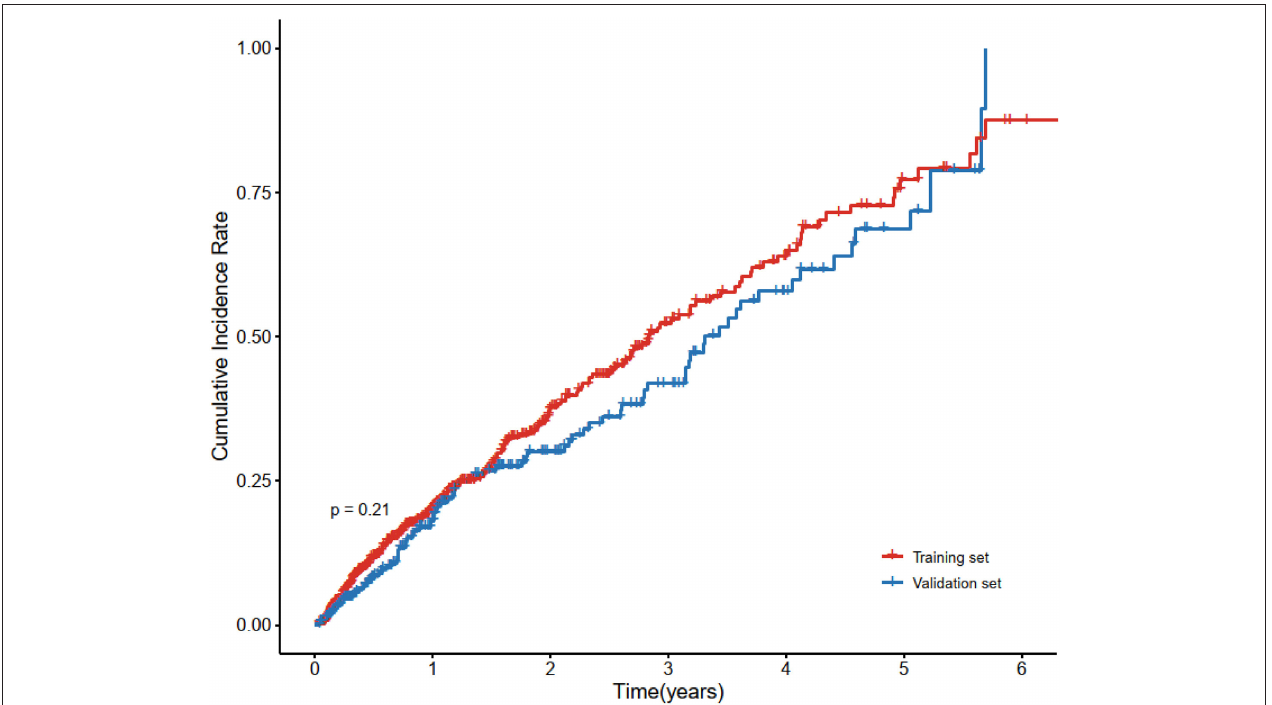
FIGURE 2 | Cumulative incidence curve of cardiovascular disease in the training set and validation set. Cardiovascular disease is the composite of coronary heart disease, cerebrovascular disease, congestive heart failure, and peripheral arterial disease. There was no statistically significant difference between the survival of the two sets using the log-rank test ( p = 0.21).